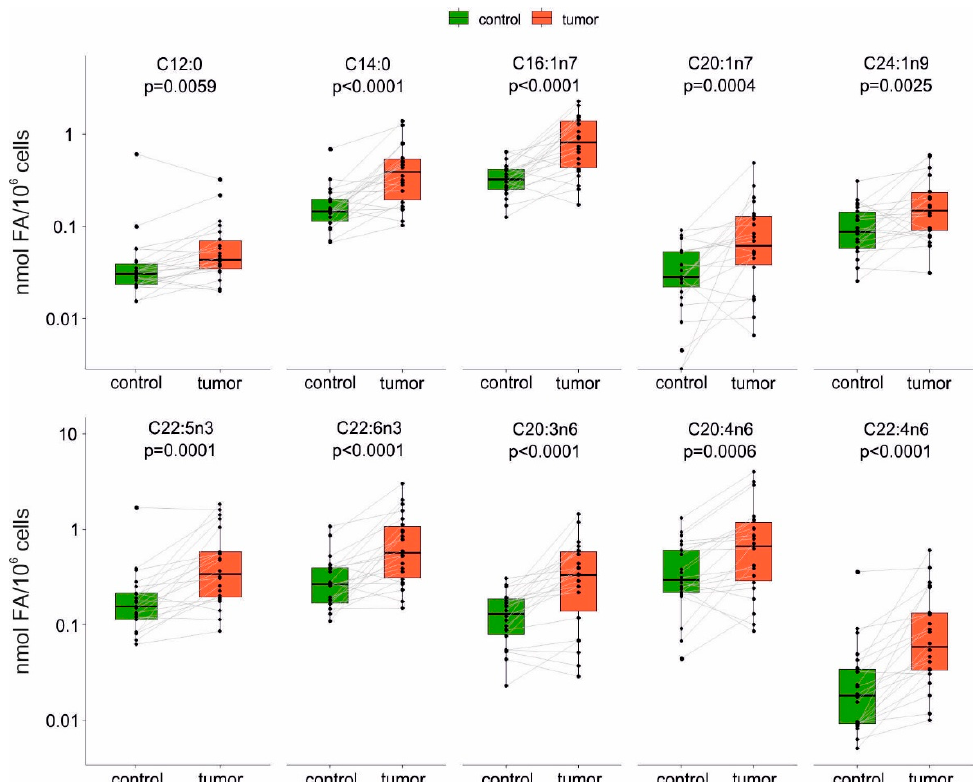
Figure 1. The amounts of individual fatty acids (FAs), which were found to be specifically increased in tumor EpCAM + cells as compared with the cells isolated from the adjacent non-tumor (control) tissue (n = 22). Values of non-tumor and corresponding tumor cells from the same patients are linked in pairwise graphs and the respective p -values are indicated above each pair of box plots.